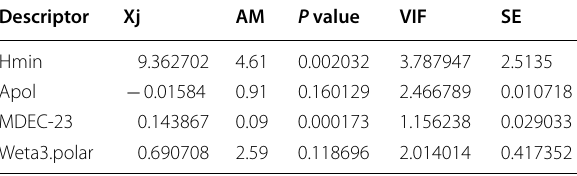
Table 3 Statistical consideration to validate the descriptors